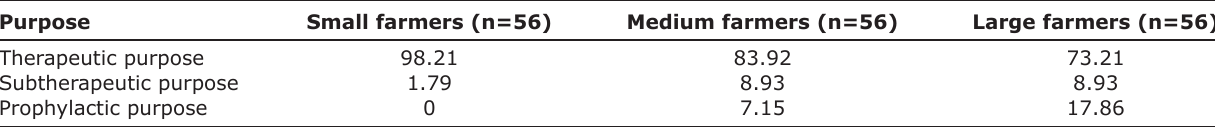
Table-4: Distribution of respondents according to purpose of antibiotic use (n=168).